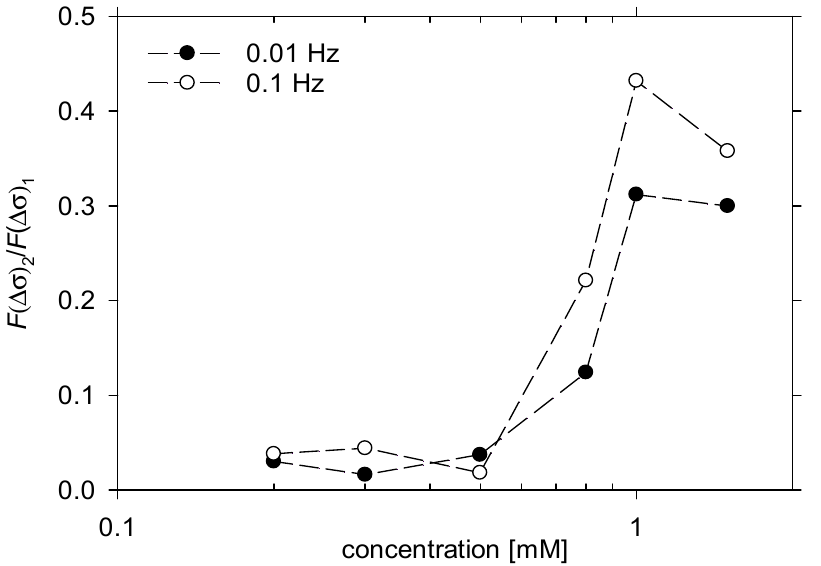
Figure 7. The dependence of the ratio of second to first harmonics in the Fourier spectrum of surface tension oscillations on LAE concentration for frequency of 0.01 Hz and 0.1 Hz. Lines were drawn to guide the eye.